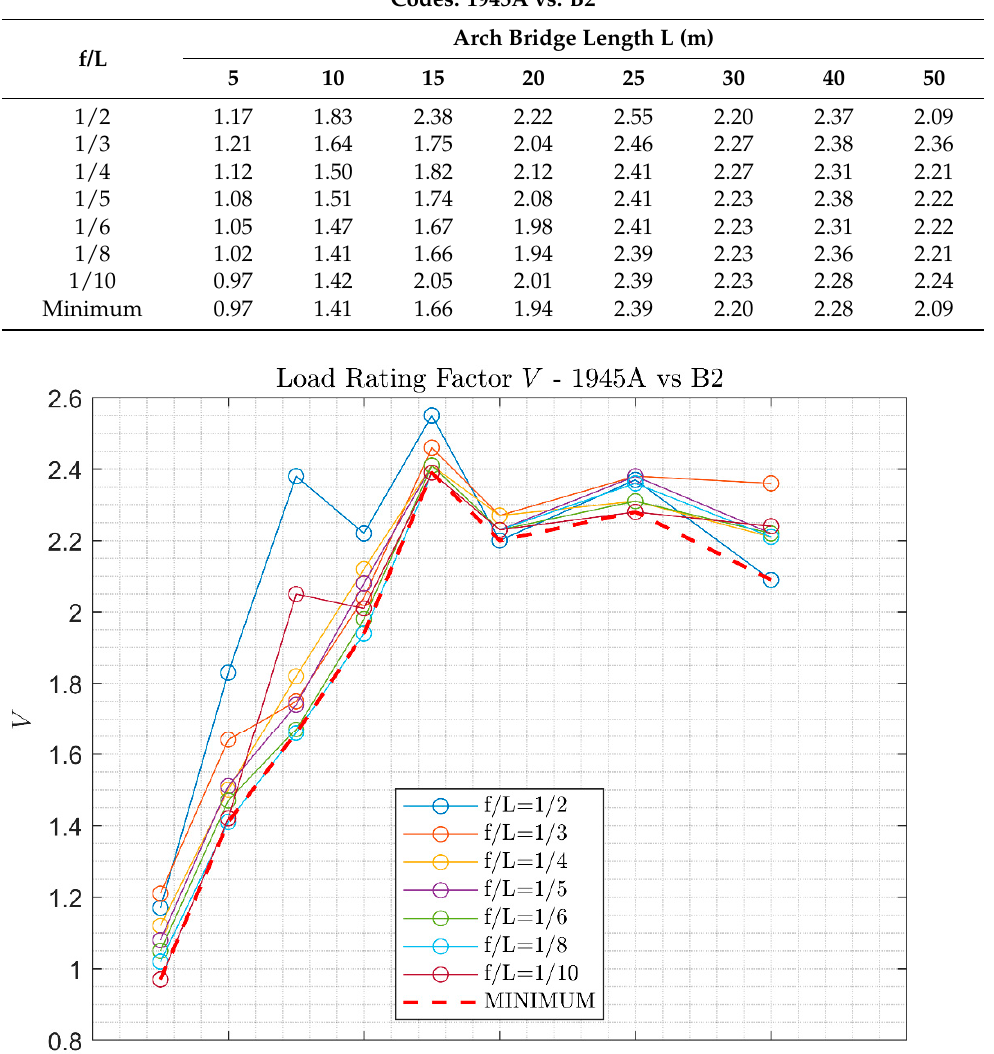
Table 3. Load Rating Factors 𝑉 for the 1925, 1926, 1945A, and 1945B design loads, and the B2, C3, and D4 lines.